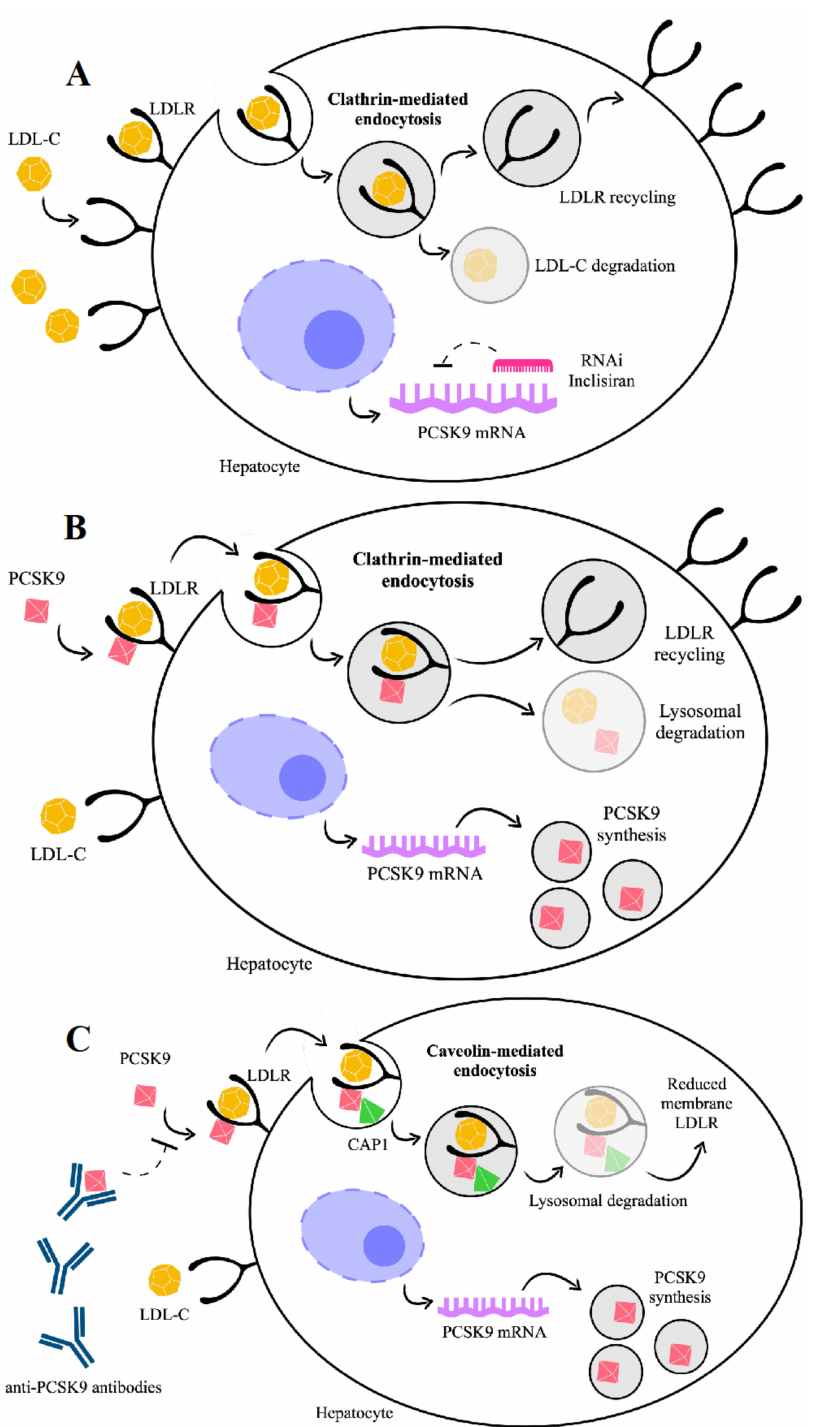
Figure 2. PCSK9 effects on targeting low-density lipoprotein receptor (LDLR) towards lysosomal degradation or recycling, depending on PCSK9 binding to cyclase-associated protein 1 (CAP-1). In the absence of PCSK9 ( A ), the LDLR-LDL complex is internalized into endosomes through a clathrin-dependent mechanism and LDLR is recycled to the cell surface. In the presence of PCSK9, the LDLR-LDL complex is internalized into endosomes through a clathrin-dependent mechanism ( B ) and LDLR is recycled to the cell surface if CAP-1 binding to PCSK9 does not occur. Instead, LDLR undergoes caveolae- dependent endocytosis ( C ) and lysosomal degradation if CAP-1 binds PCSK9. To inhibit PCSK9 action, two approved types of drugs, which are antibody based, act through targeting the extracellular PCSK9 (alirocumab, evolocumab), or through the small interfering RNA, targeting the intracellular synthesis of PCSK9